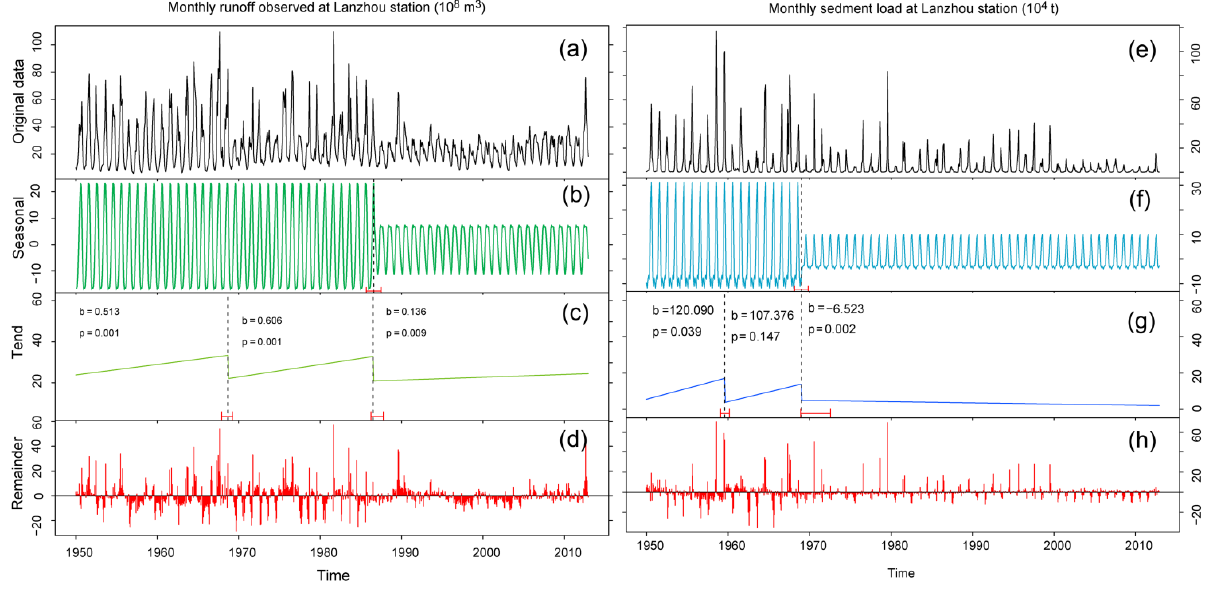
Figure 3. Monthly runoff and sediment load decomposition at the Lanzhou station. ( a , e ) Observed monthly runoff and sediment, ( b , f ) seasonal components of runoff and sediment decomposed by BFAST; ( c , g ) trends components of monthly runoff and sediment load decomposed by BFAST; ( d , h ) residues of runoff and sediment among observation, seasonal and trends